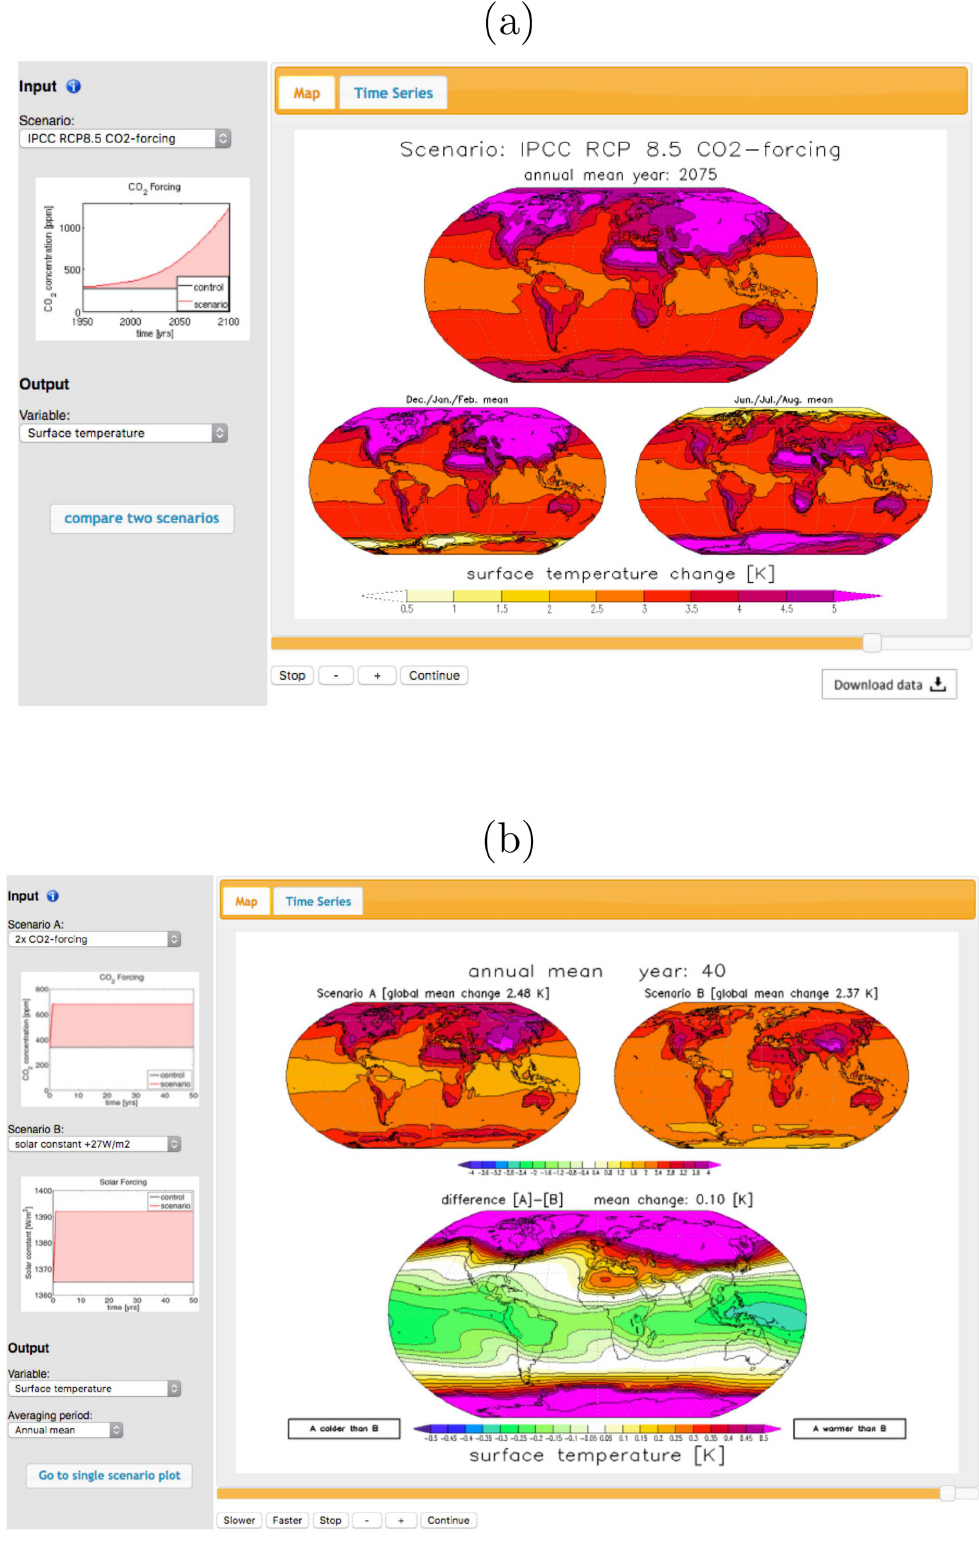
Figure 3. Examples of the MSCM scenario interface. (a) A single scenario (here RCP8.5 CO 2 forcing) and (b) the comparison of two different scenarios (here a CO 2 forcing is compared against a change in the solar constant by + 27Wm − 2 )